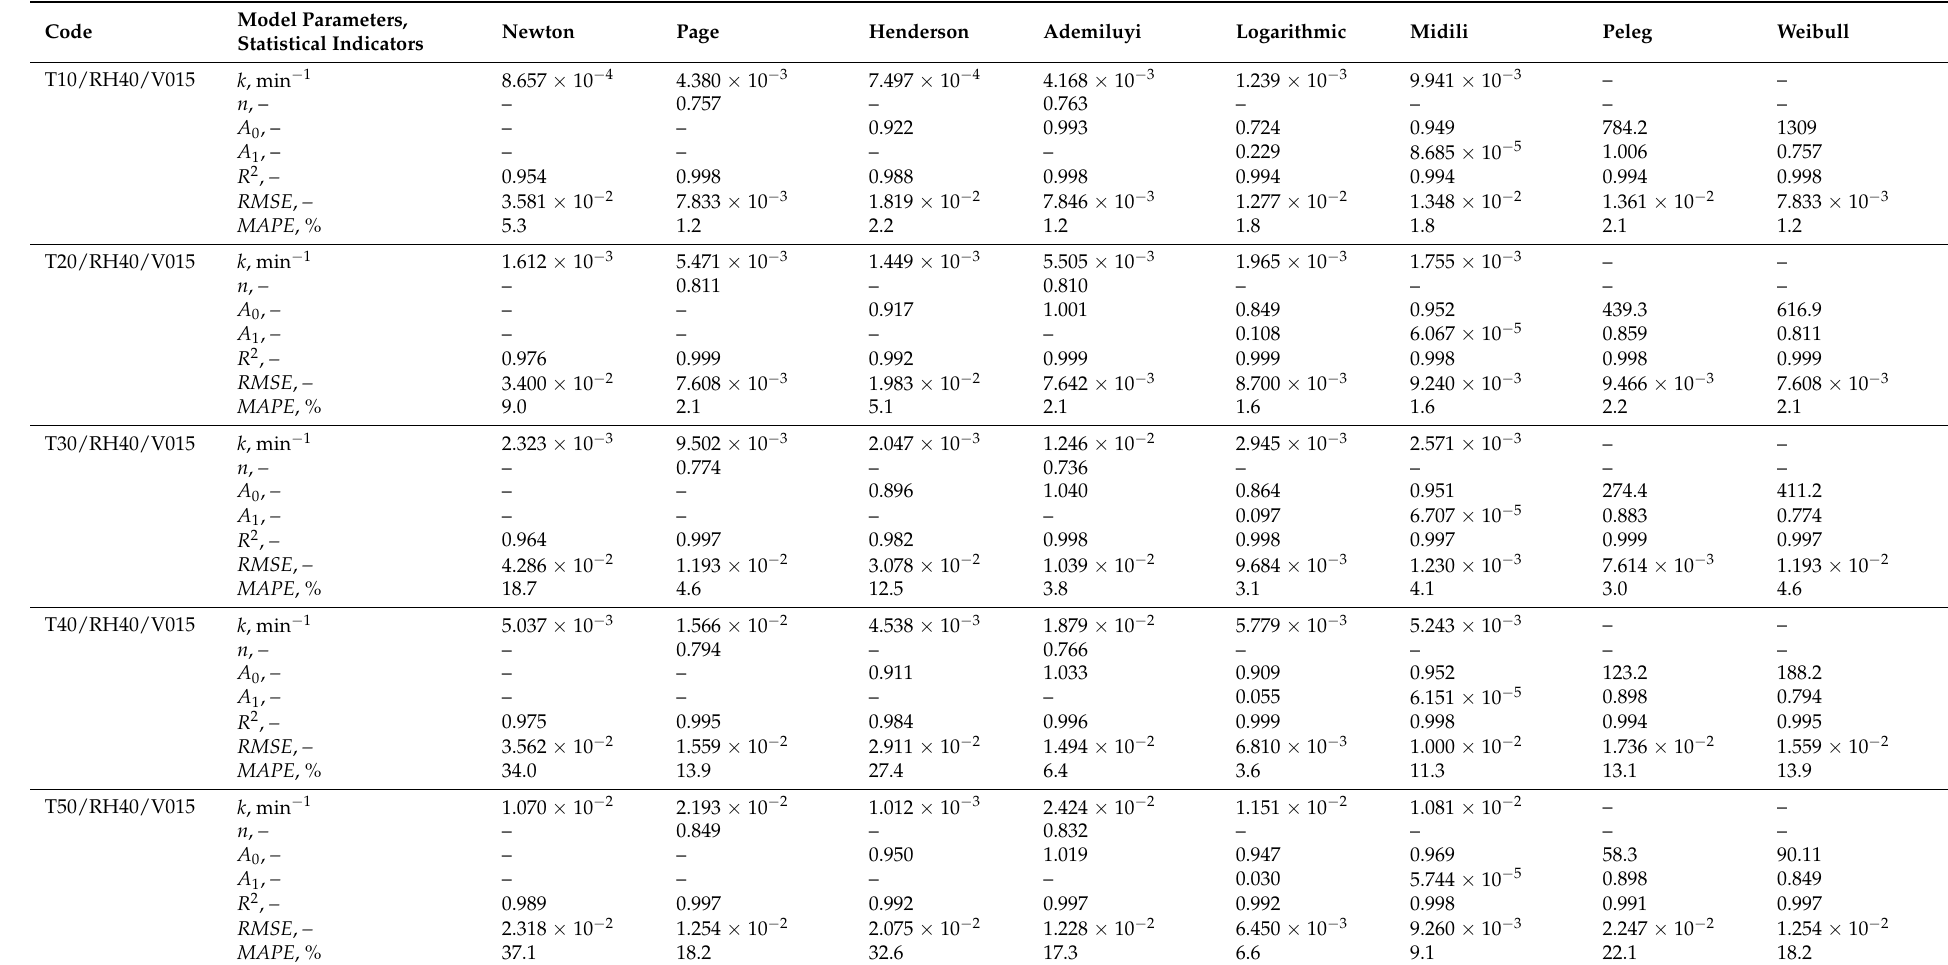
Table 2. Summary of drying constant k , coefficients n , A 0 , A 1 , coefficient of determination R 2 , root means square error RMSE and mean absolute percentage error MAPE observed from fitting of semi-empirical models with the experimental